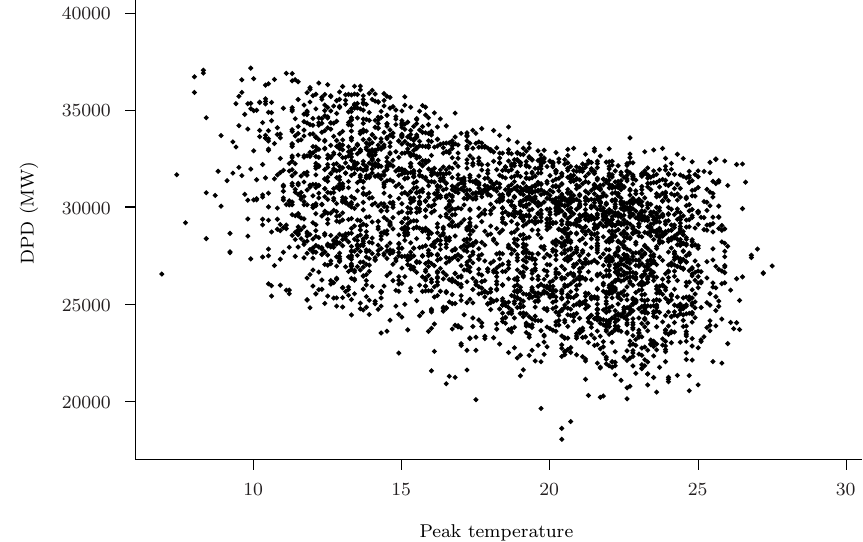
Figure 4: Scatter plot of daily peak demand against peak temperature (in o